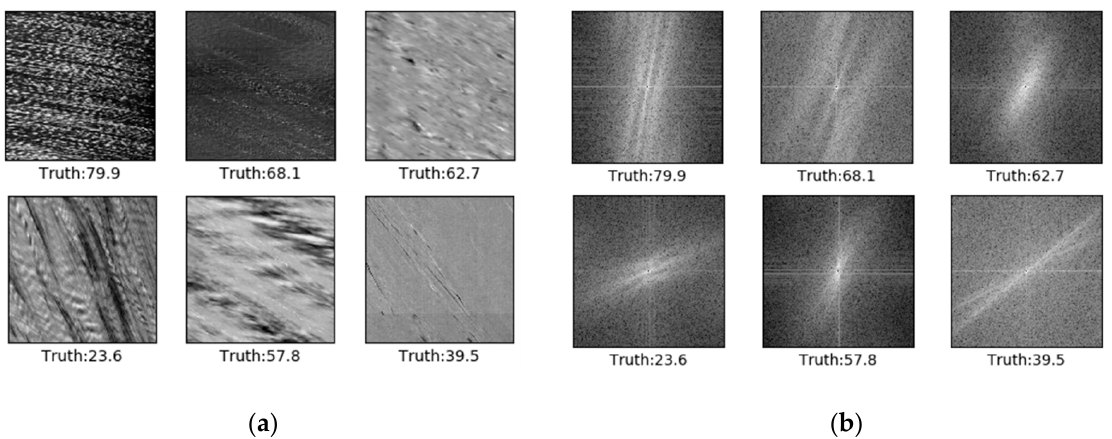
Figure 17. Additional training data collected from real river videos. ”Truth” labels indicate correct (ground truth) angles (in